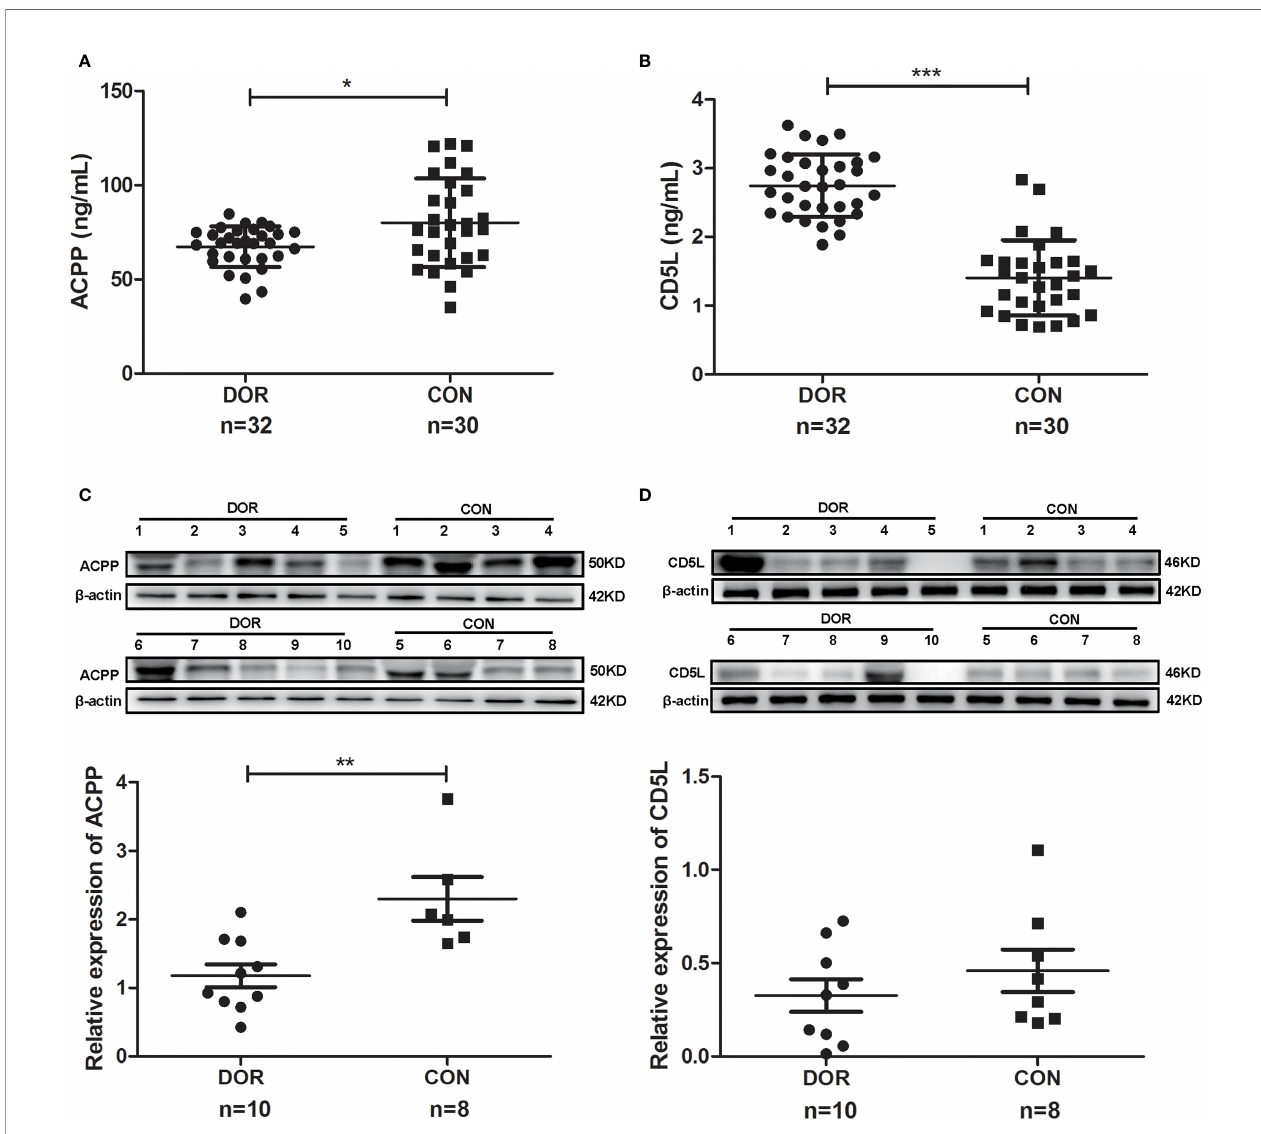
FIGURE 5 | Proteins expression levels change between diminished ovarian response (DOR) patients and controls (CON) in follicular fl uid and cumulus cells. (A) Prostatic acid phosphatase (ACPP) and (B) CD5 antigen-like (CD5L) levels in follicular fl uid were analyzed by enzyme-linked immunosorbent assay. (C) ACPP and (D) CD5L levels in cumulus cells were analyzed by western-blot. * P < 0.05; ** P < 0.01; *** P <